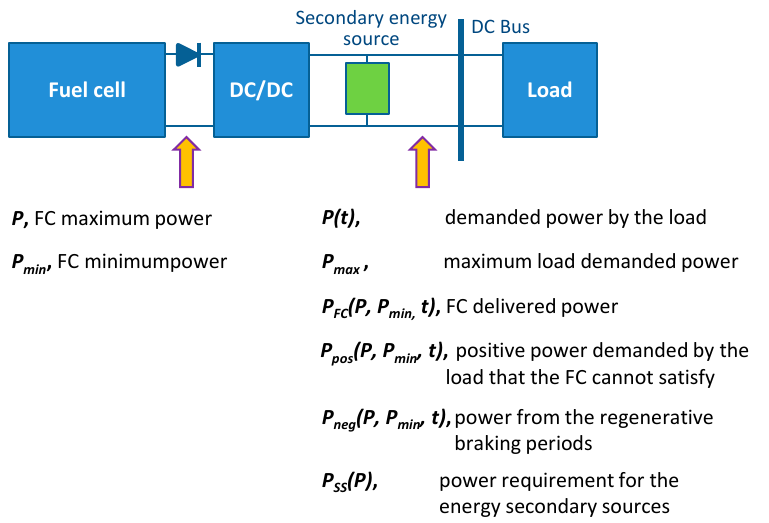
Figure 2. Each power definition placement within the power distribution architecture.